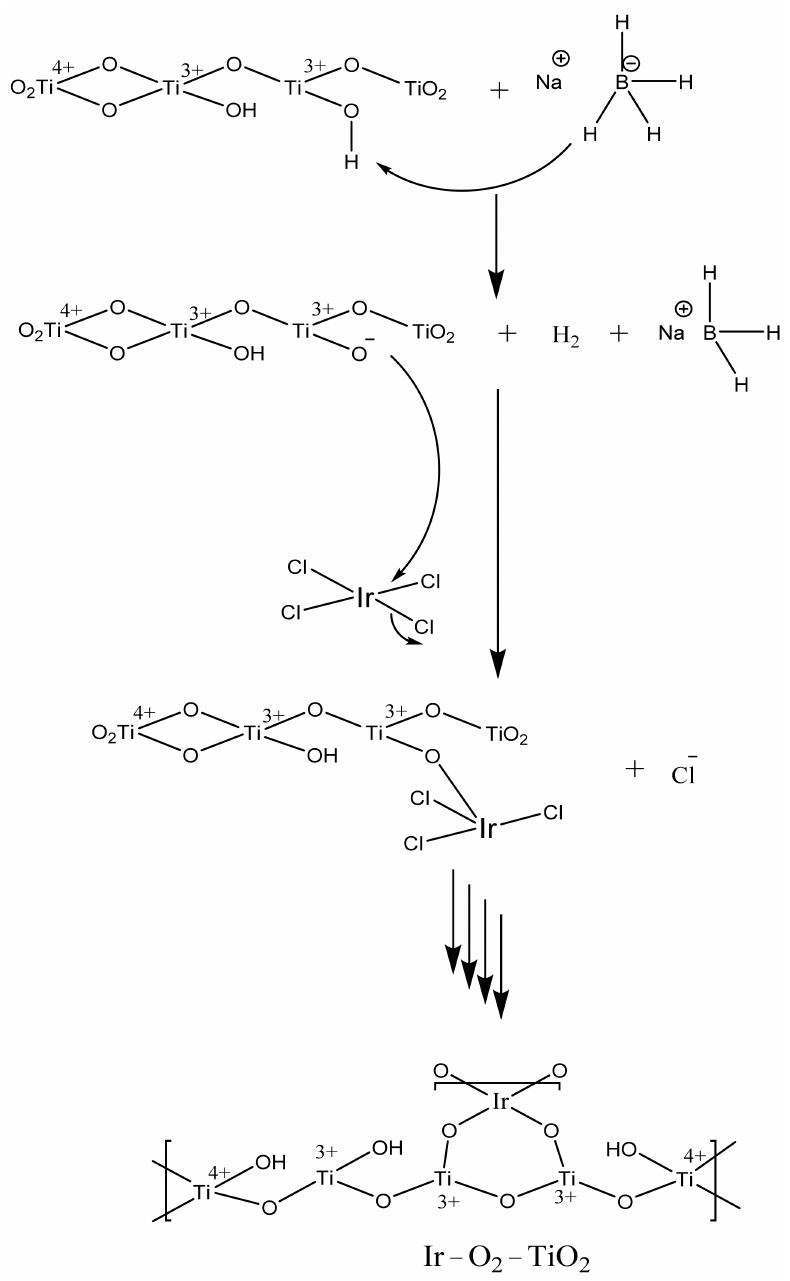
Figure 5. Growth schematic illustrate a covalently bonding of Ir on blue TiO 2